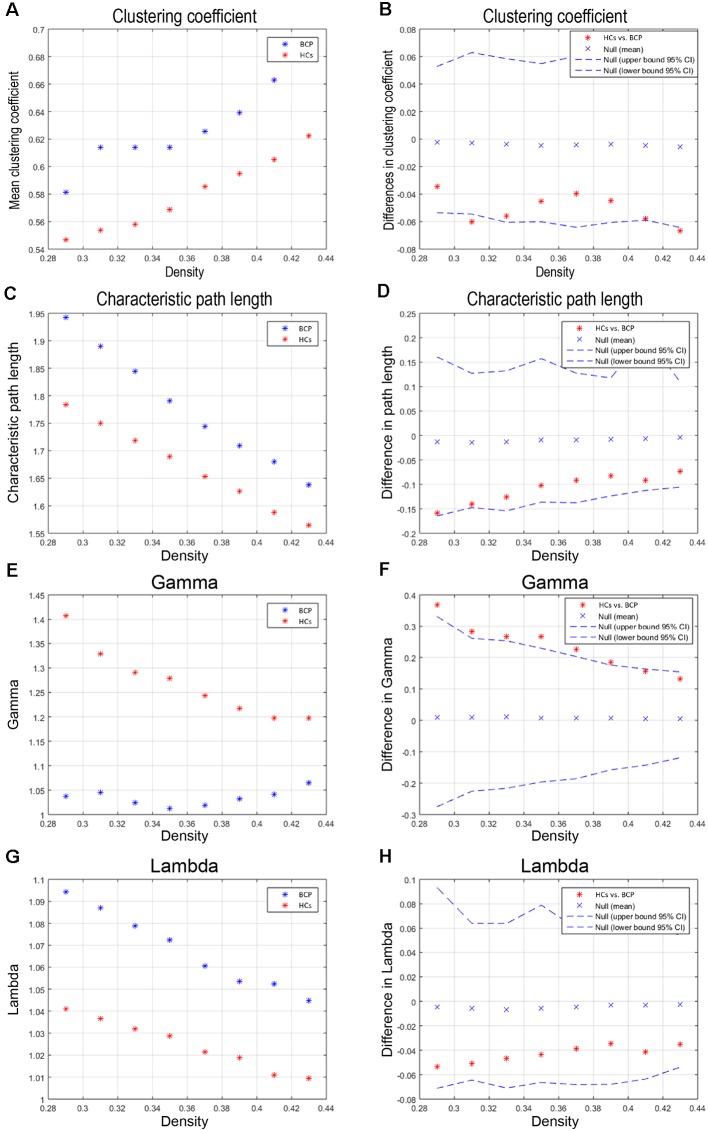
Within-group global network measures, and between-group differences in these measures. Clustering coefficient (A,B), Characteristic path length (C,D), Gamma (E,F), and Lambda (G,H) of the BCP and HC networks. The red star indicates the difference between the two groups (B,D,F,H). The value of gamma is significantly lower in BCP group. BCP, bilateral cerebral palsy; HCs, healthy controls.